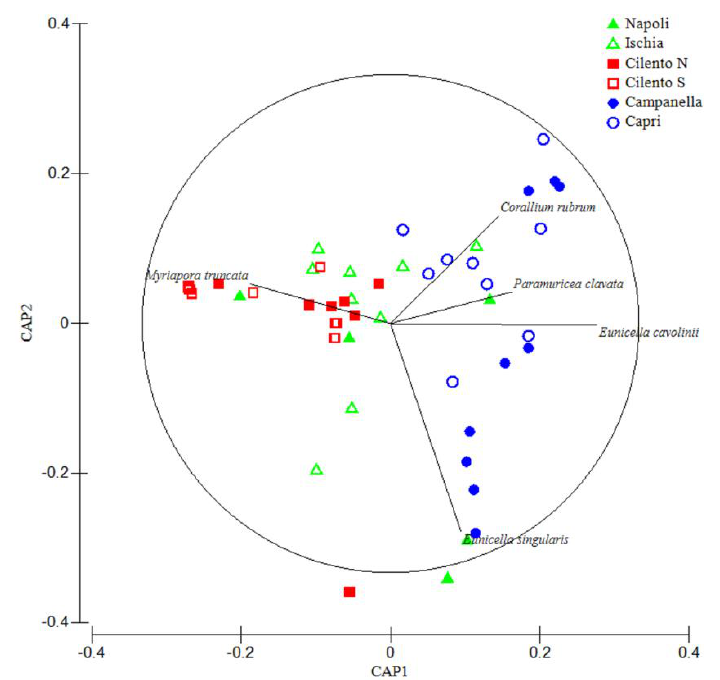
Figure 4. The CAP analysis on CSS densities; straight lines are vectors of species whose orientation and length are proportional to the most correlated areas. Only species with a correlation Pearson index > 0.4 are shown. The circle represents a 95% confidence